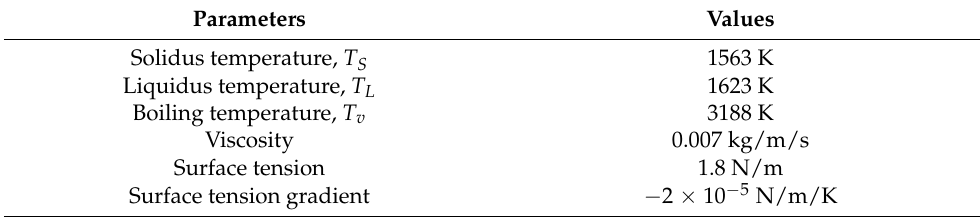
Figure 6. Temperature-dependent material properties of Inconel 625 [19]. Table 2. Properties of IN625 in a thermo-fluid simulation.